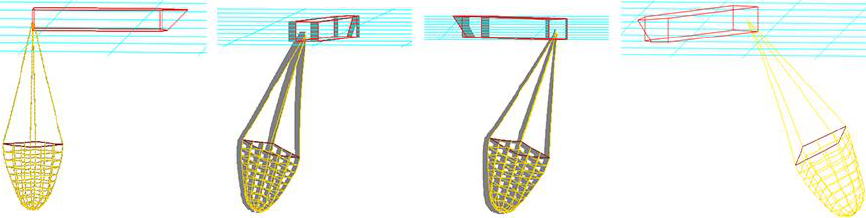
Figure 20. Shape changes of rigid truss trawl rotating towing under fixed turning radius at v = 1 m/s.